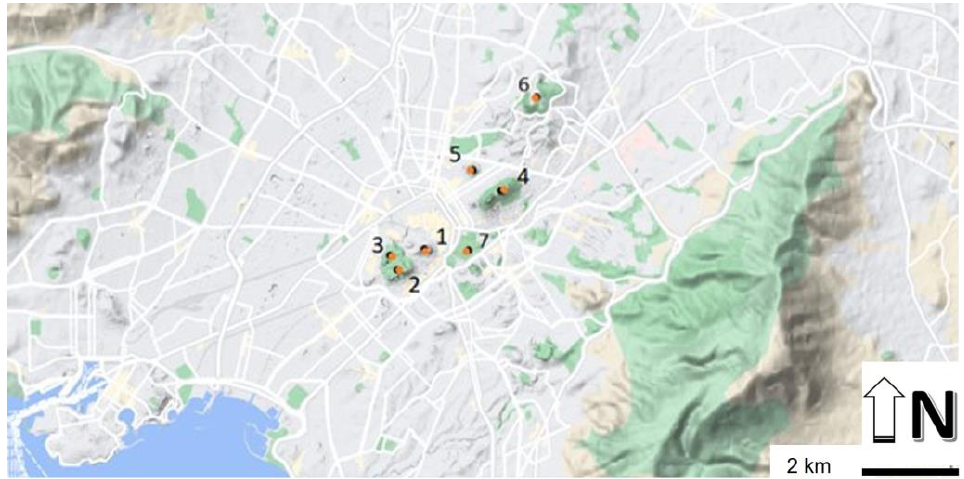
Figure 3. Satellite photo of Athens city indicating the location of the hills of the city. 1 . Akropolis, 2 . Filopappou 3 . Hill of the Nymphs 4 . Lycabettus 5 . Hill of Strefi 6 . Tourkovounia 7 . Ardittos Hill